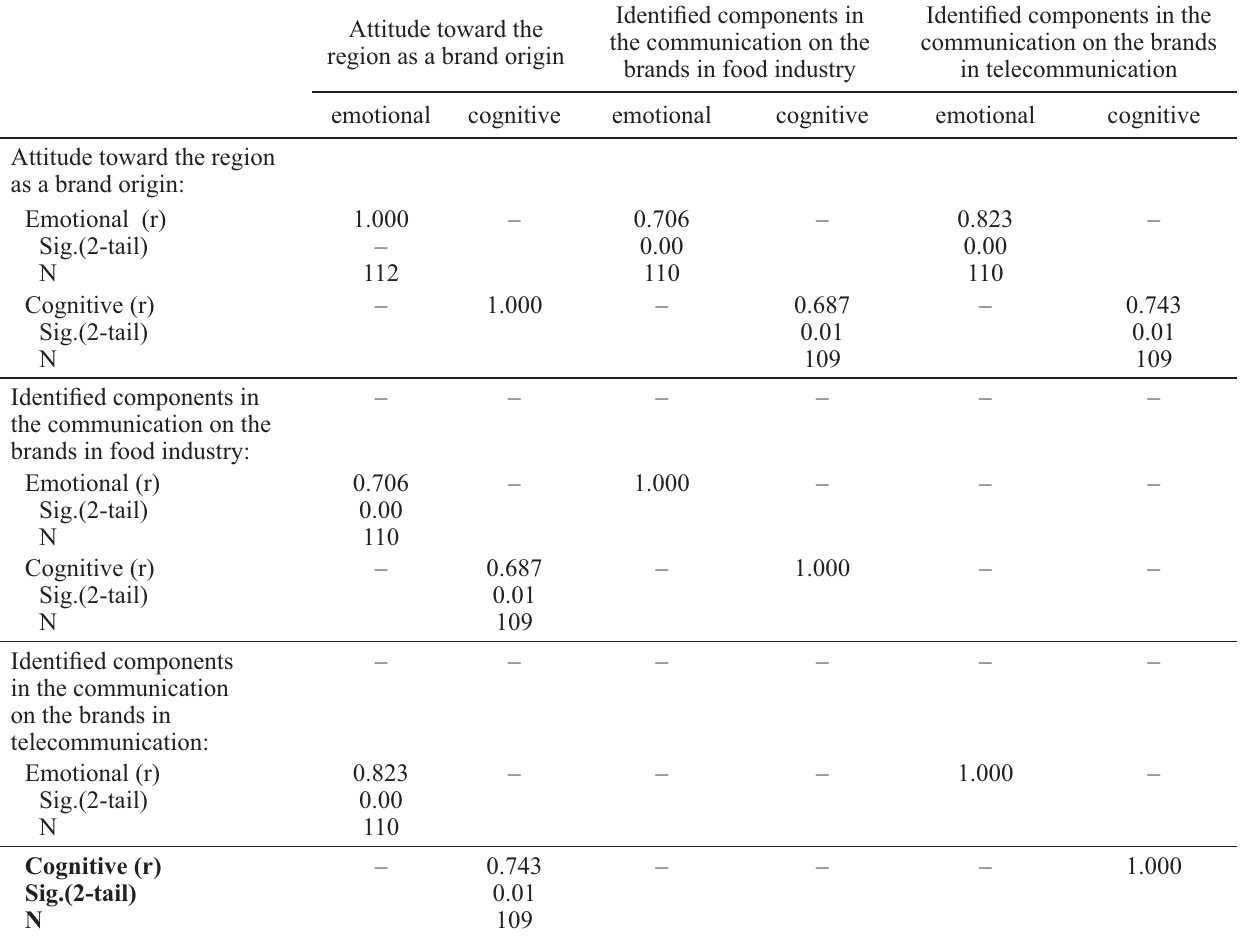
Table 3. Pearson correlation coeffi cient between respondents’ attitude toward the Baltic Sea region as a brand and perception of the communication on the brands on emotional and cognitive